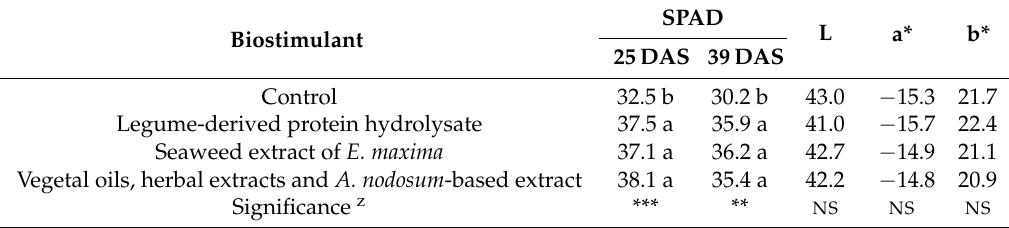
Table 2. The effect of biostimulant treatments on the Soil Plant Analysis Development (SPAD) index and Hunter color parameters L* (brightness), a* (+a*= red; − a* = green) and b* (+b* = yellow; − b*= blue) of leaves in greenhouse spinach